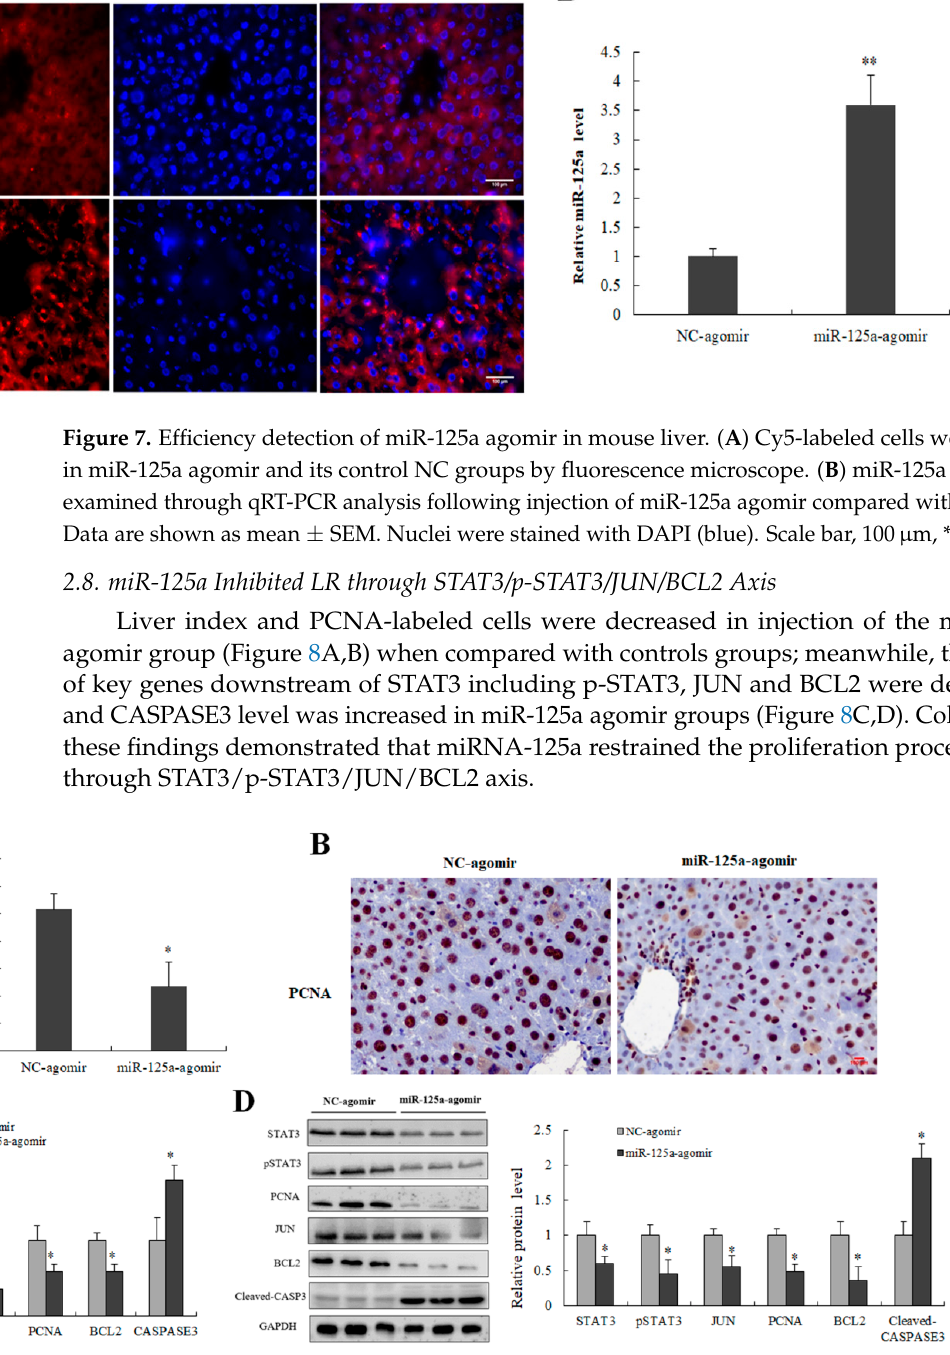
Figure 8. miR ‐ 125a inhibited LR through STAT3/p ‐ STAT3/JUN/BCL2 axis in vivo. ( A ) Liver index (liver weight/body weight ratio) was measured at 48 h post ‐ PH after transfection of miR ‐ 125a agomir/NC through tail vein injection. ( B ) Representative IHC staining of PCNA (brown) on liver sections obtained from transfection of miR ‐ 125a agomir/NC through tail vein injection mice at 48 h post PH; Scale bars: 100 μ m. ( C ) STAT3, JUN, BCL2, PCNA as well as CASPASE3 were detected by qRT ‐ PCR in liver tissue after transfection of miR ‐ 125a agomir/NC through tail vein injection at 48 h post ‐ PH. ( D ) STAT3, p ‐ STAT3, JUN, BCL2, PCNA as well as Cleaved ‐ CASPASE3 were detected by WB in liver tissue after transfection of miR ‐ 125a agomir/NC through tail vein injection at 48 h post ‐ PH, the samples derive from the same experiment and that gels/blots were processed in parallel. Data were shown as mean ± SEM, * p < 0.05.